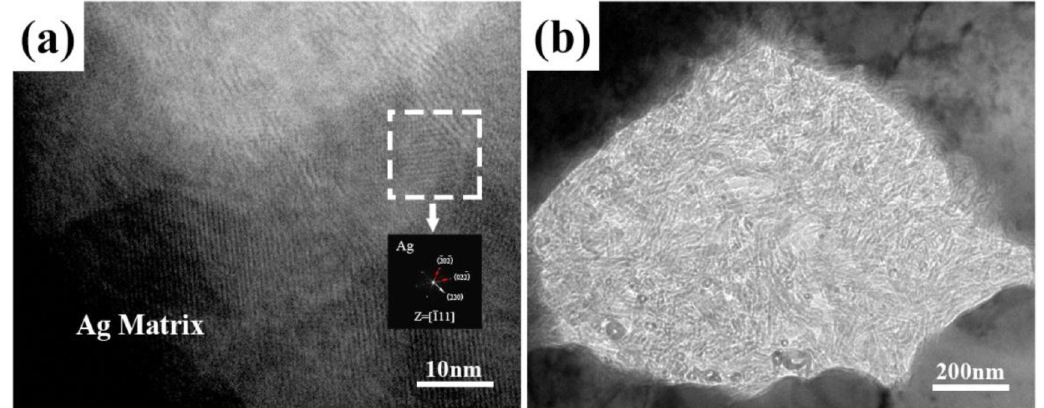
Figure 7. TEM images of CNTs @ Ag / Ag composites microstructure, ( a ) by SPS, ( b ) by HP.